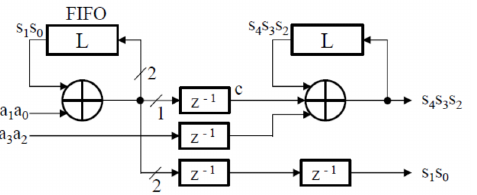
Figure 7. Pipelined averaging to reduce the adder critical path delay.